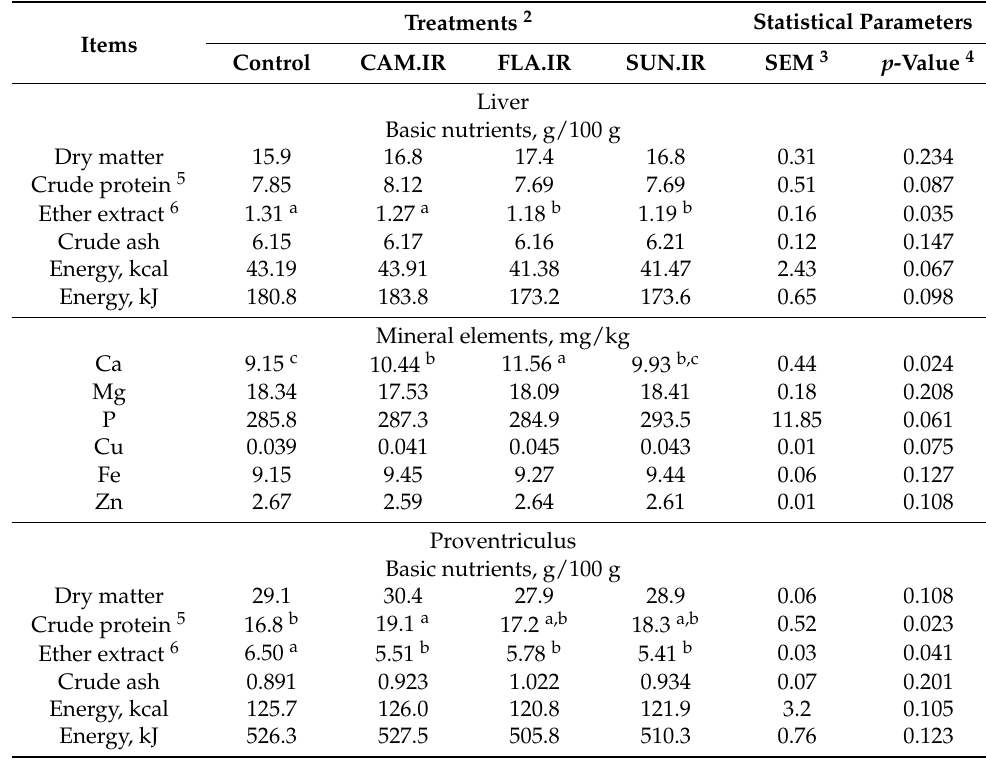
Table 5. Content of basic nutrients and mineral elements in natural matter in selected broiler chicken organs 1